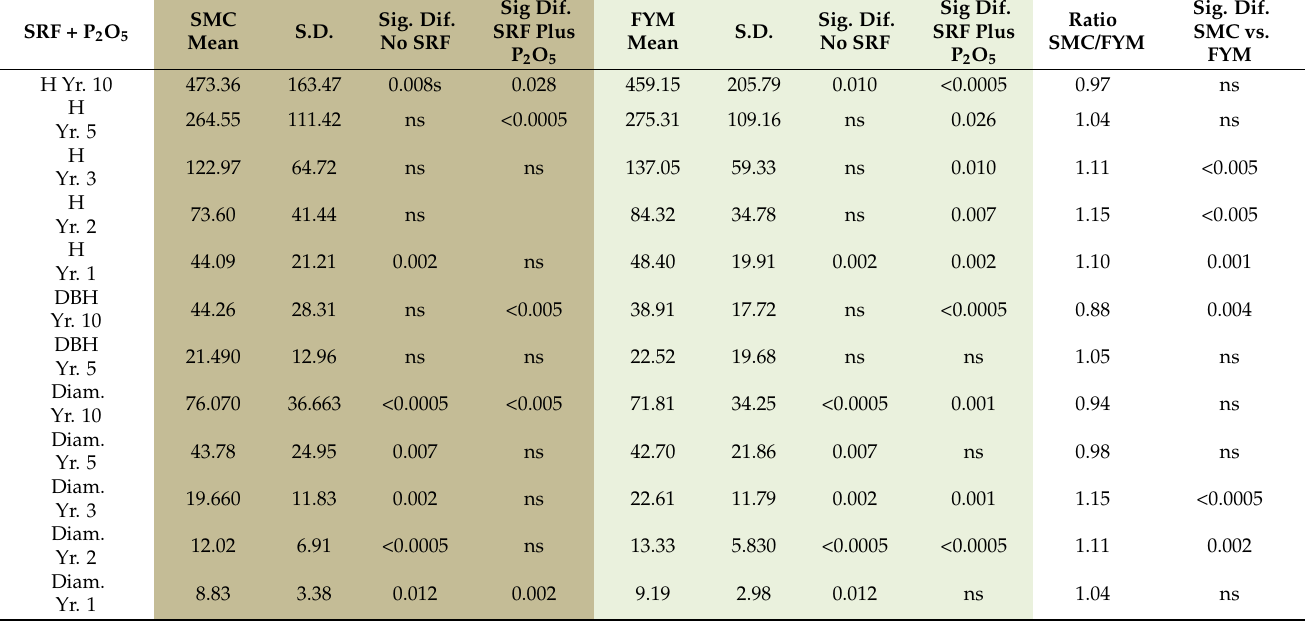
Table 9. Comparison of SMC- and FYM-planted trees given additional two-year slow-release fertilizer tablets plus superphosphate (SRF + P 2 O 5 ) (Nb: height (H): cm; DBH: mm, Diam: (diameter above root collar): mm, ratio FYM/SMC, ns: differences not